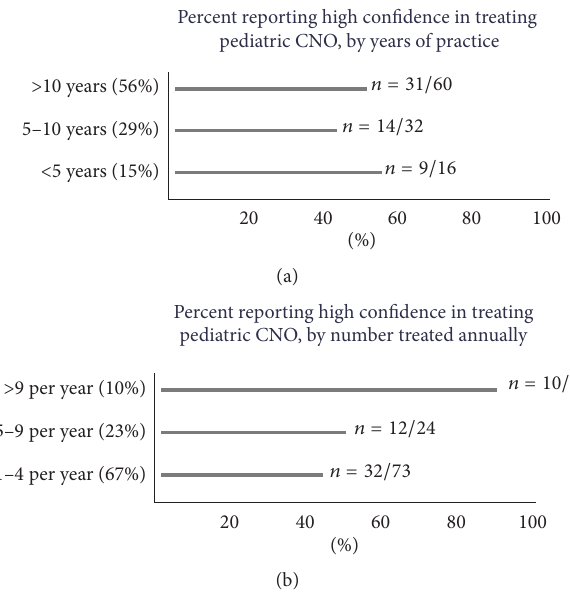
Figure 2: Level of confidence of physicians in treating patients with CNO, (a) by years of practice and (b) by number seen annually.